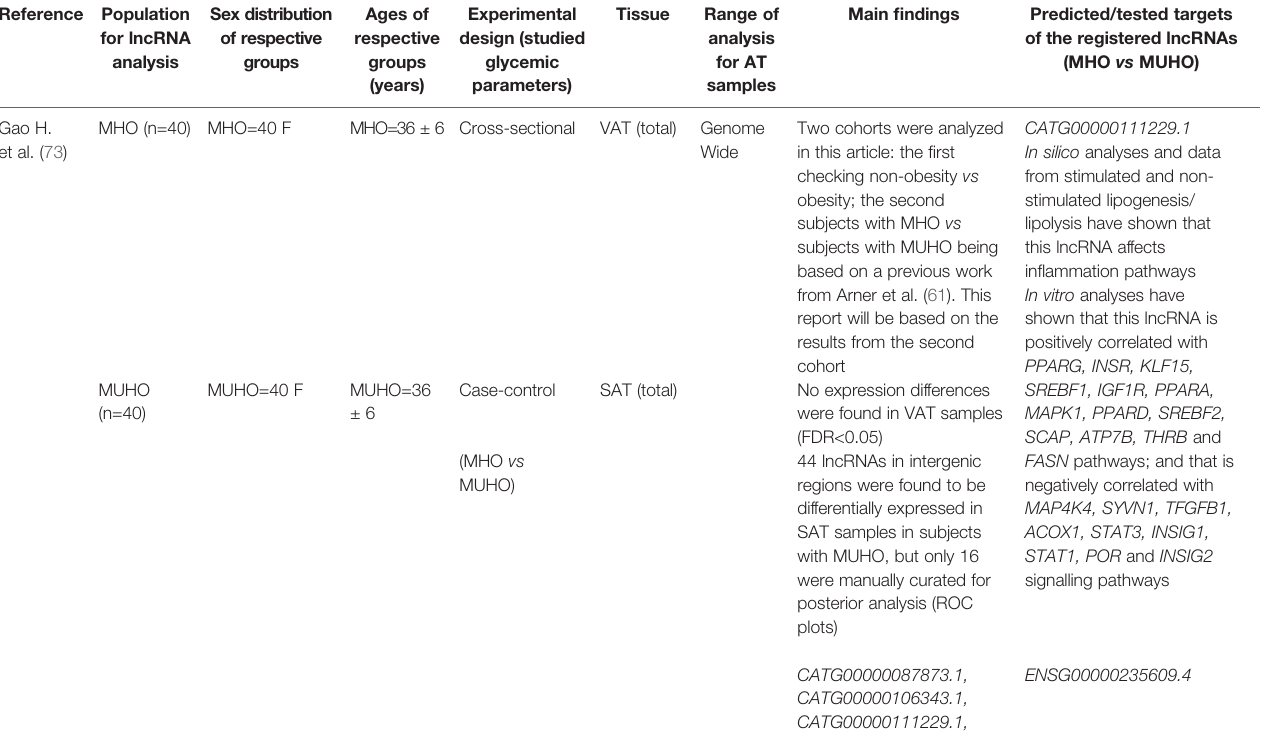
TABLE 4 | Data obtained from studies assessing lncRNA expression changes in dysglycemic states or when correlated with glycemic